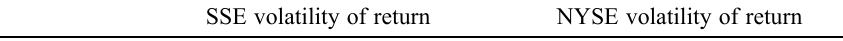
Table 3. Means and variances of volatility of returns The table shows the means and variances of the volatility of returns for Shanghai Composite Index (SSE) and the NYSE Composite Index (NYSE). The volatility of returns is calculated as the absolute value of the change in the natural logarithm of the price index in a given period. The price index is obtained from DataStream Equity Indices. The sample period is from